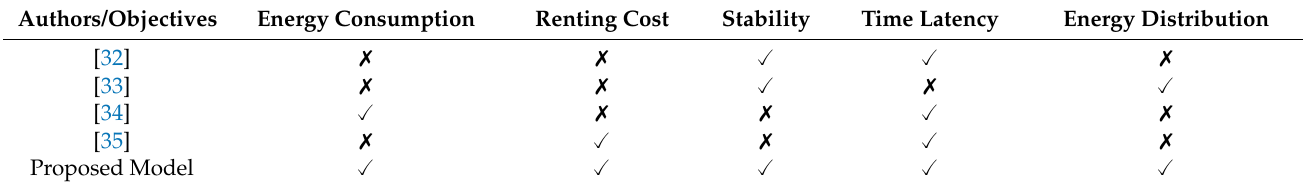
Table 1. Summary of the covered objectives in the fog computing model in the